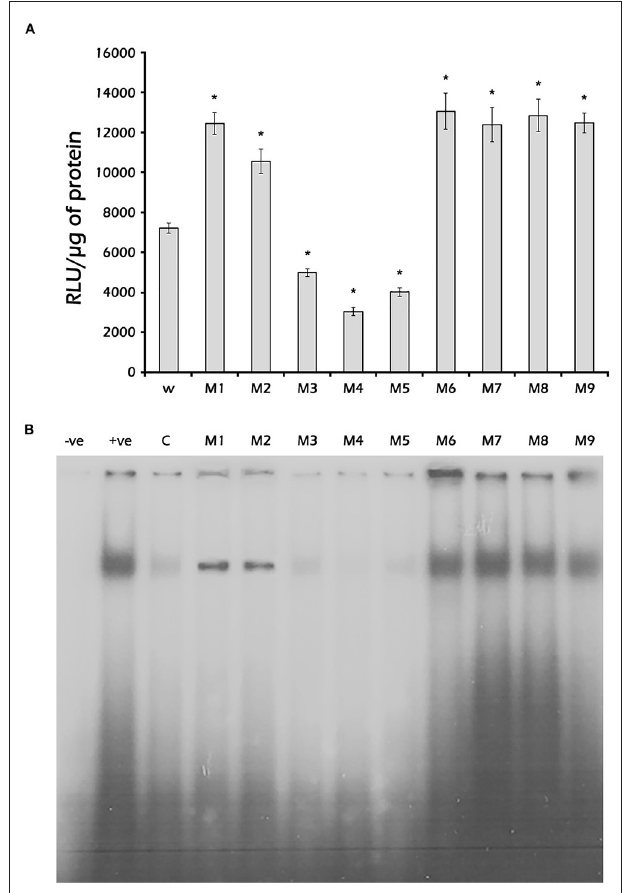
FIGURE 6 | Identification of critical nucleotides base influences the binding of nuclear proteins. (A) Luciferase activity: Sf 9 cells were transfected with the pGL3 − 204 bp construct or its mutants (M1–M9) ( Supplementary Table 1 ). Then, the transfected cells were grown in a medium containing 1 µ M JH III for 48h. The cells were harvested, and luciferase activity was measured and normalized to mg protein. Mean ± SD ( n = 3). (B) EMSA: Nuclear proteins were isolated from previtellogenic female fat body cells and incubated with 32 P-labeled double-stranded 31-bp oligonucleotides probes corresponding to the Vg2 RE sequence or its mutants (M1–M9) ( Supplementary Table 1 ). The DNA-protein complexes were separated on a 5% non-denaturing polyacrylamide gel. The wild-type 31-bp Vg2 RE competed with a 50-fold excess of cold probe (lane C) or cold mutants (lanes M1–M9). The negative